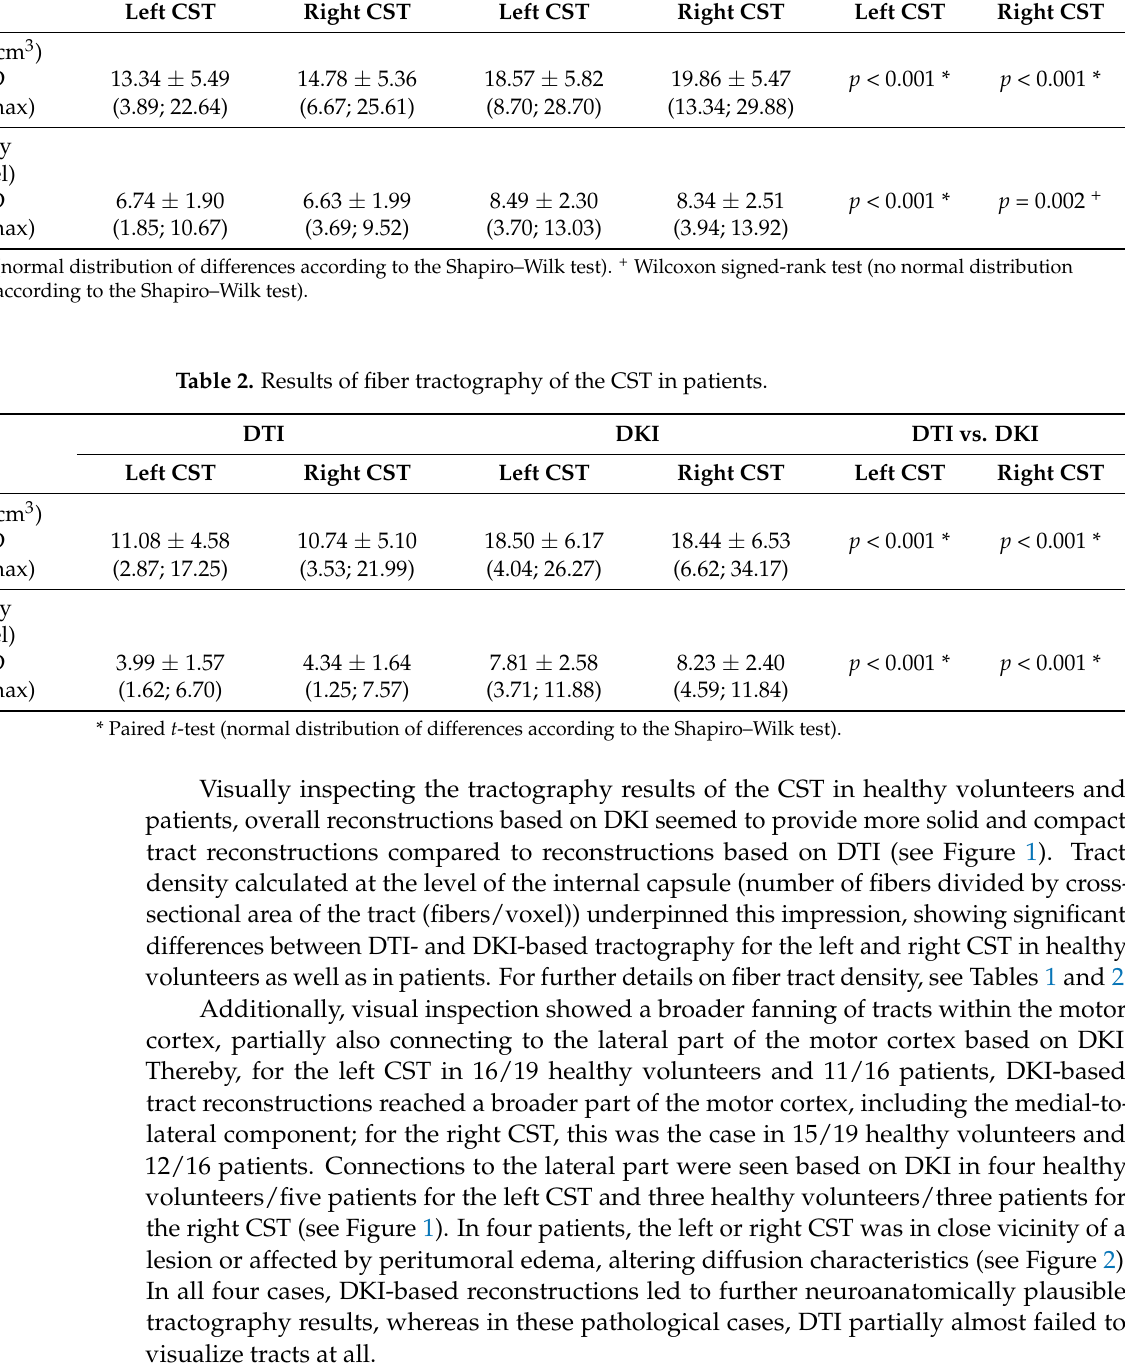
Table 1. Results of fiber tractography of the corticospinal tract (CST) in healthy volunteers. Diffusion Tensor Imaging (DTI)